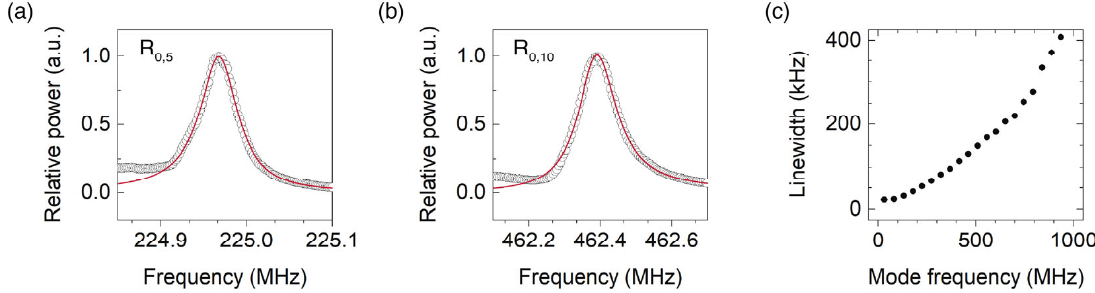
Figure 3. Acoustic resonances ( a ) R 0,5 and ( b ) R 0,10 —experimental points and fitted Breit–Wigner– Fano functions—and ( c ) linewidth of R 0,m resonances versus the frequency.